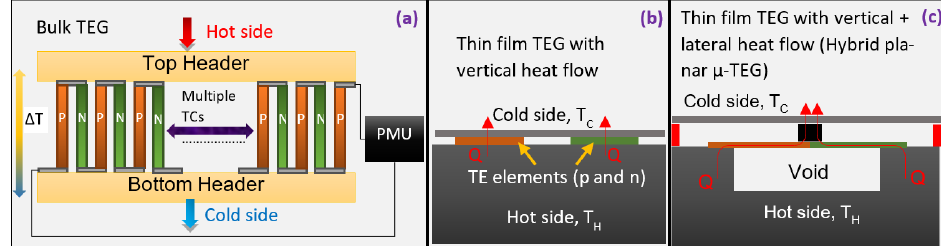
Figure 1. ( a ) Conventional bulk TEG design with p-type and n-type thermoelectric legs placed between two headers. ( b ) A thin film TEG with vertical heat flow. ( c ) A thin film TEG with vertical and lateral heat flow, classified as a hybrid planar TEG.